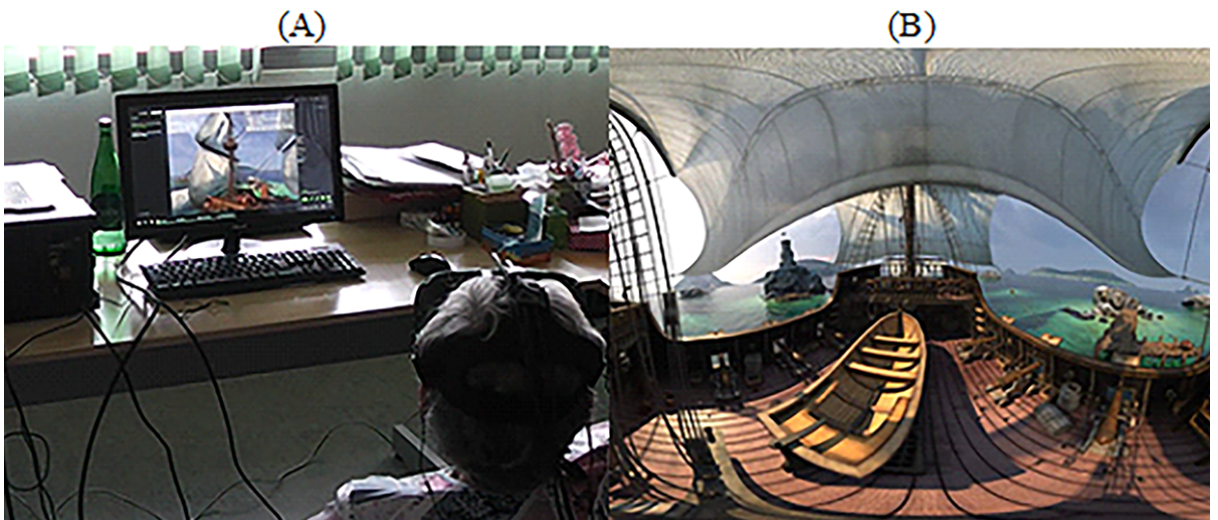
Figure 11. Observing the virtual environments: Ghost Ship. (A) Participants observe an interactive video using the head-mounted display. (B) Screenshot of the Ghost ship sailing in the Caribbean